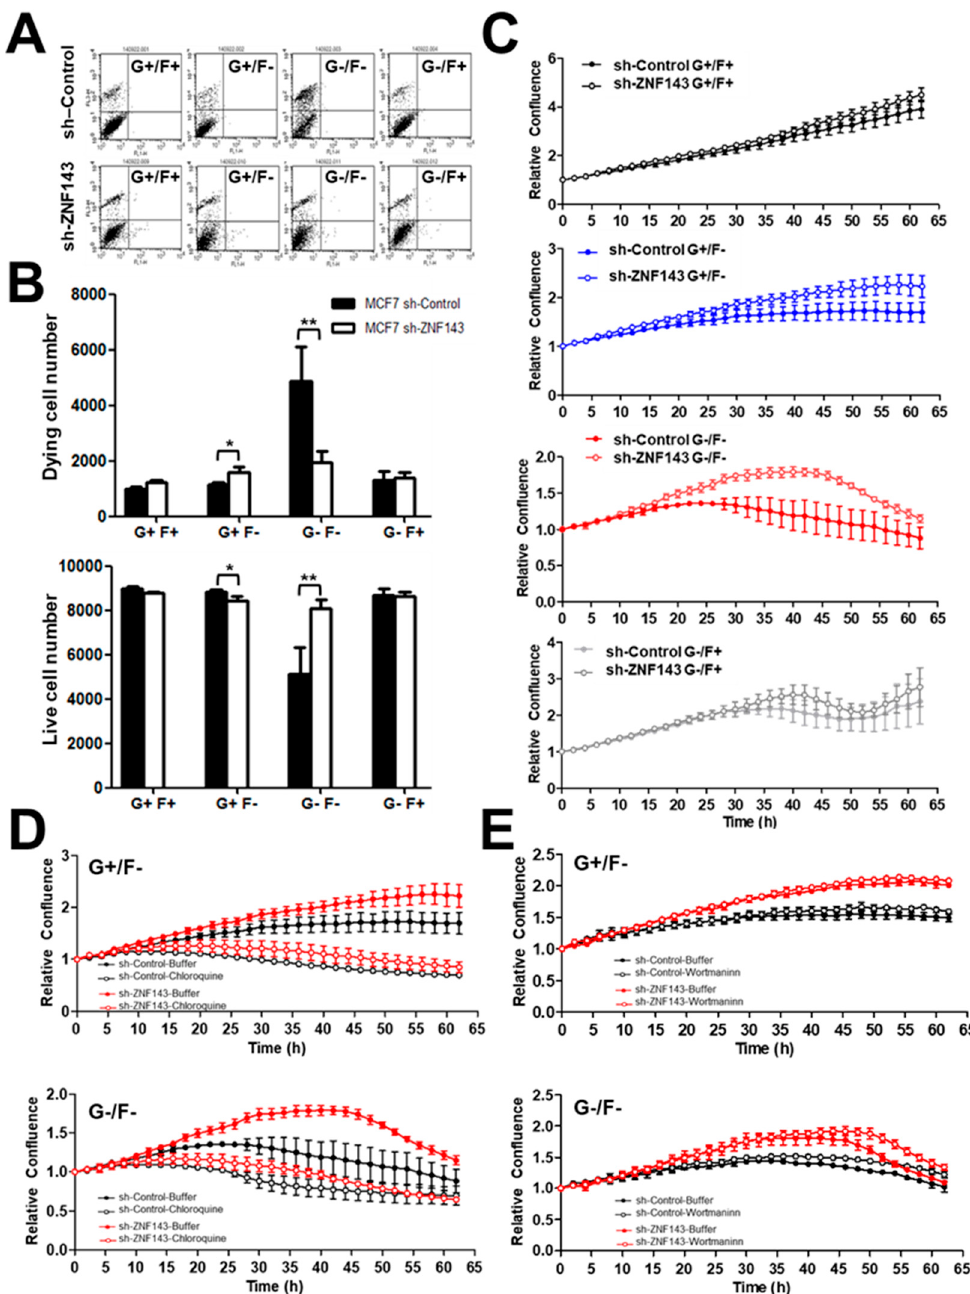
Figure 1. Breast cancer cells with decreased ZNF143 show better survival in glucose- and/or FBS-deprived conditions, which are chloroquine-dependent. ( A , B ) MCF7 sh-Control and sh-ZNF143 cells were grown in four different conditions for 24 h, and viable cells were counted by fluorescence-activated cell sorting. G and F denote glucose and FBS, respectively. ( C – E ) Cells were plated on 96-well plates and grown for 24 h. The cells were then maintained in four different conditions in terms of FBS and glucose, and cell survival or growth was monitored by capturing images every 2 h over 4 days. Cells were maintained in the presence of 10 µ M chloroquine ( D ), 100 nM Wortmannin ( E ), or dimethysulfoxide (vehicle). Relative confluency is shown in the graphs. Data are expressed as means ± S.E. of at least three independent experiments. Statistical significance was assessed using paired Student’s t -tests (* p < 0.05 and ** p < 0.005). Results shown are representative of at least three independent experiments.